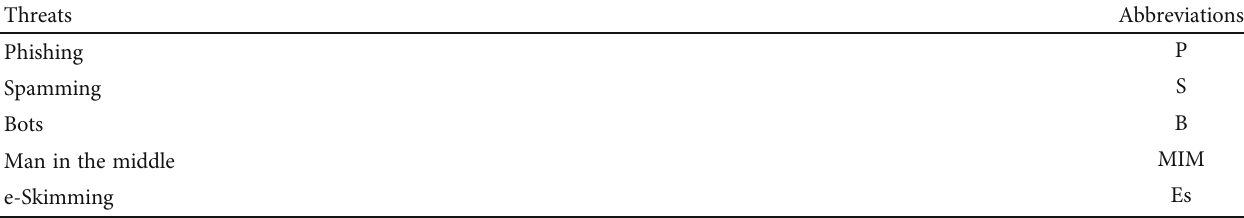
Table 2: Summary of